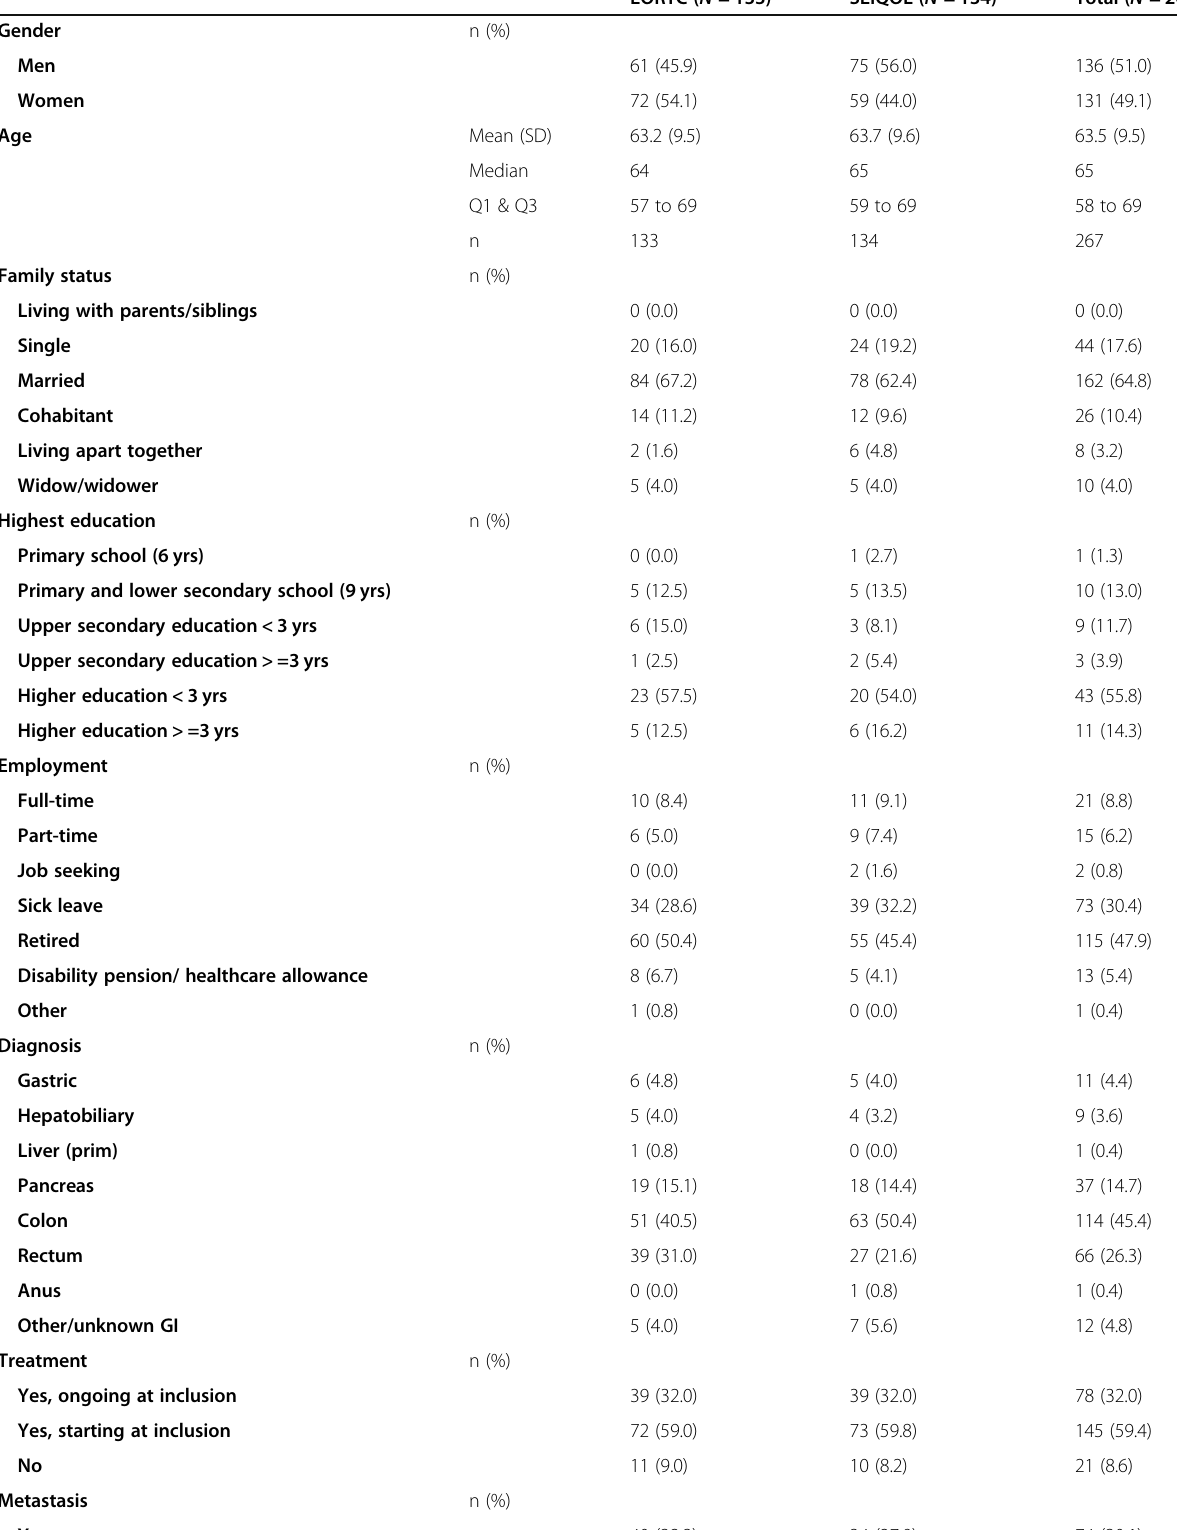
Table 1 Description of patients with at least one